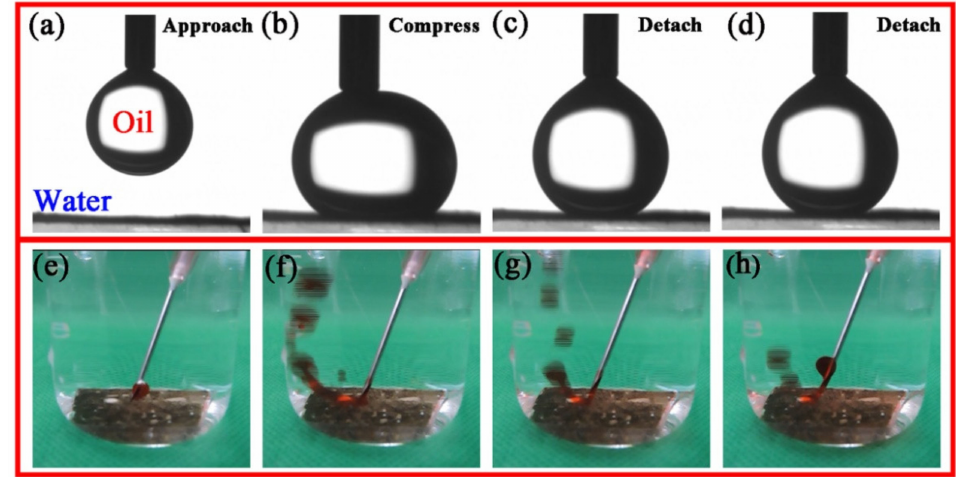
Figure 7. Photos recording underwater measurement of PDA@PAN nanofirous membrane droplet resistance ( a – d ) and oil-resistance performance ( e – h ) in